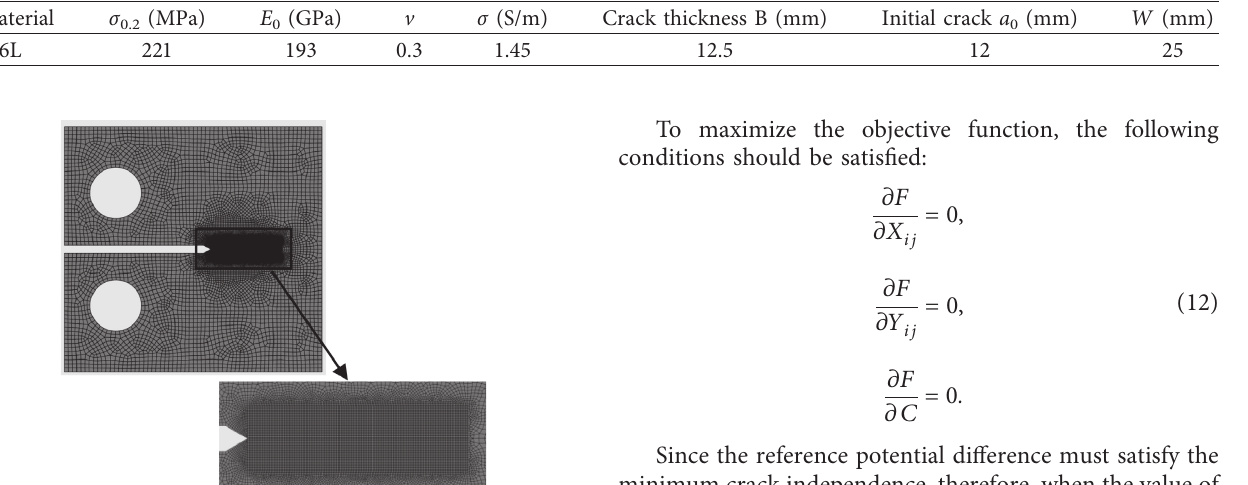
Table 1: Material properties and geometric parameters of the specimens.